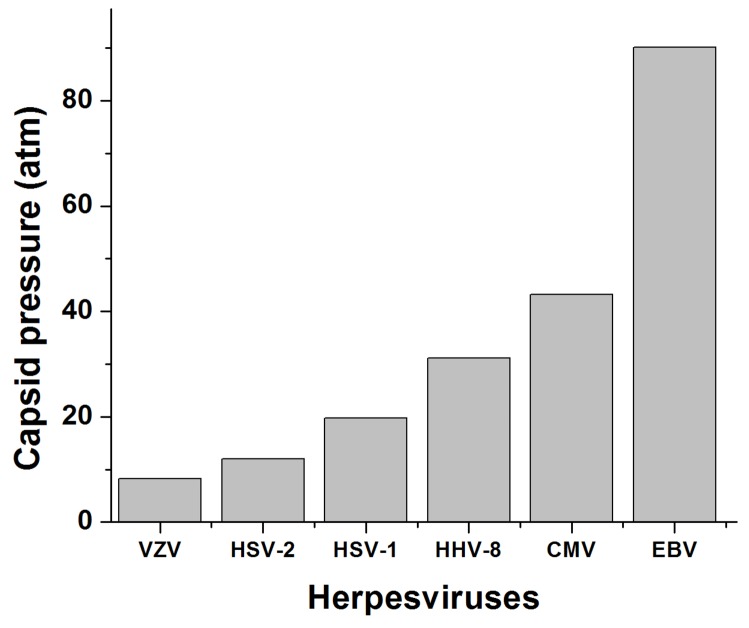
Calculated DNA pressures in herpesvirus capsids.The analytical expression used to calculate pressures inside virus capsids is based on a theoretical model from refs. (Grayson et al., 2006; Purohit et al., 2005; Purohit et al., 2003; Tzlil et al., 2003) that involves forces generated by DNA-DNA electrostatic repulsive force and DNA bending stress, which depend on the DNA packing density. DNA packing density in the capsid was estimated with values for packaged DNA length and inner capsid radius derived from previous Cryo-EM data (Booy et al., 1991; Germi et al., 2012).